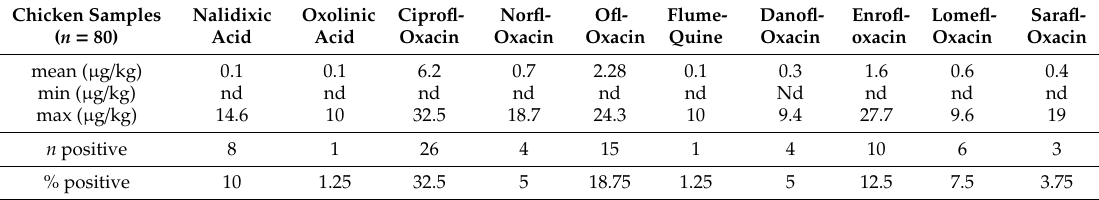
Table 5. Occurrence in the 80 chickens samples of